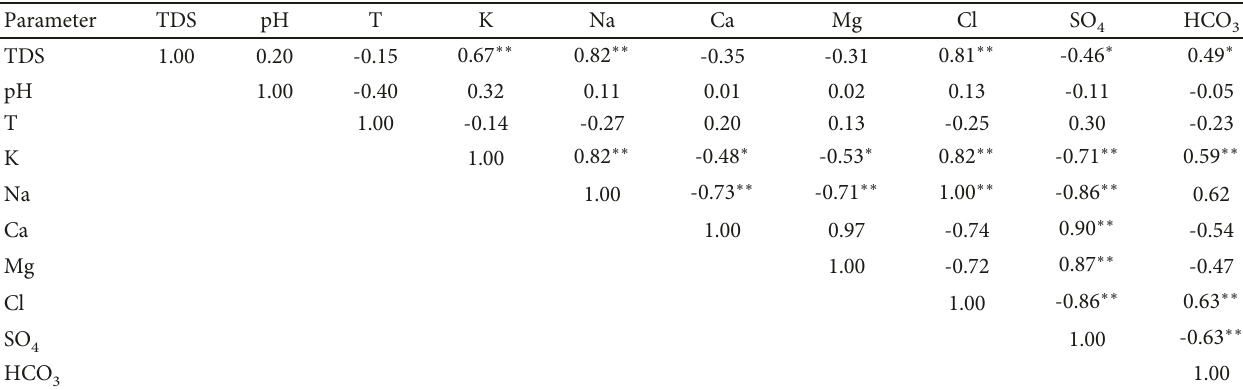
Table 5: Correlation matrix of physical and chemical parameters of the saline and salty springs (well) in eastern Sichuan Basin. Parameter